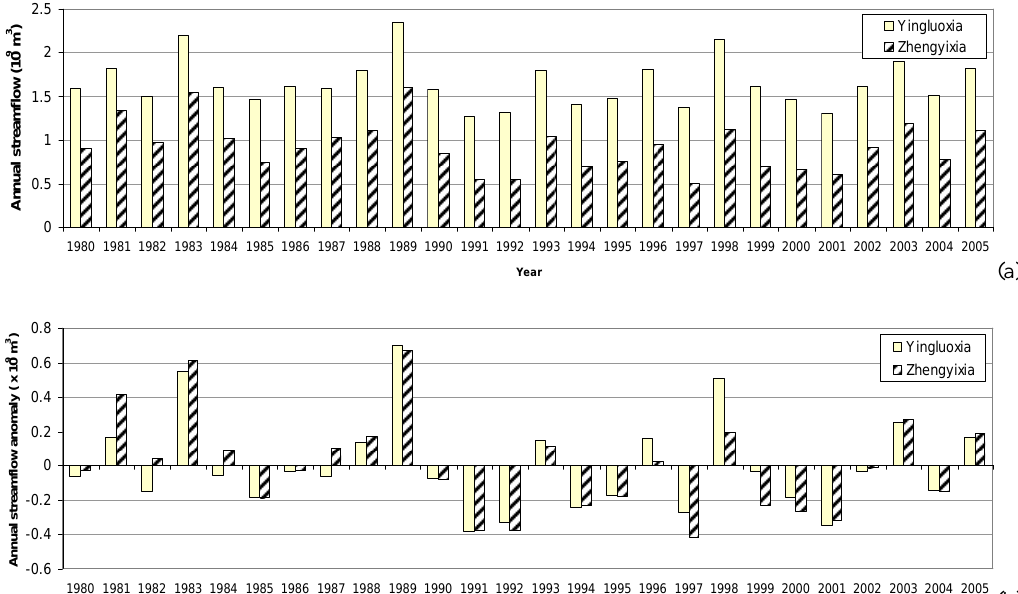
Fig. 5. (a) The annual streamflow and (b) the anomaly of the annual streamflow at Yingluoxia and Zhengyixia from 1980 to 2004. Fig. 5. The annual river streamflow (a) and the anomaly of the annual river streamflow (b) at Yingluoxia Fig. 5. The annual river streamflow (a) and the anomaly of the annual river streamflow (b) at Yingluoxia and Zhengyixia hydrological stations from 1980 to 2005. monthly streamflow at Zhengyixia station in Fig. 6b. and Zhengyixia hydrological stations from 1980 to 2005.